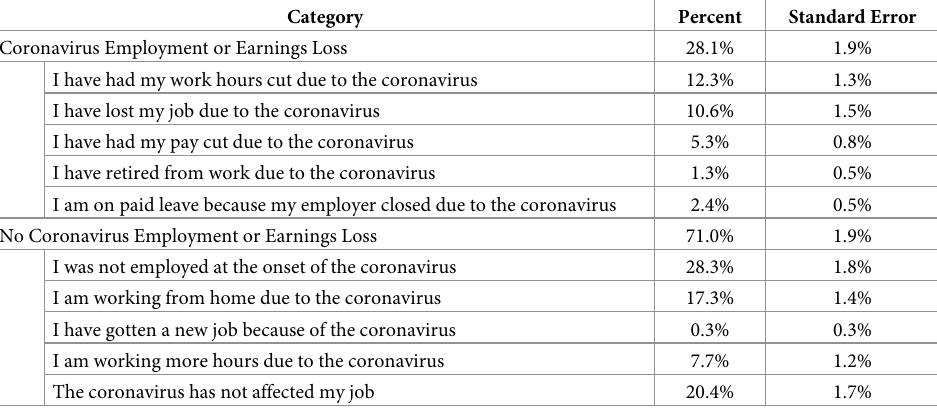
Table 2. Experience of employment or earnings loss related to